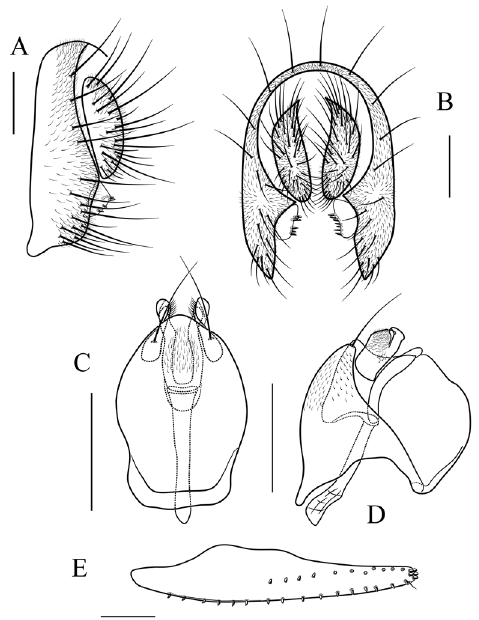
Figure 13. Scaptodrosophila nigricostata sp. n. A, B epandrium, surstylus and cercus (lateral and poste- rior views) C, D hypandrium, parameres, gonopods, aedeagus and aedeagal apodeme (ventral and lateral views) E oviscapt (lateral view). Scale bars 0.1